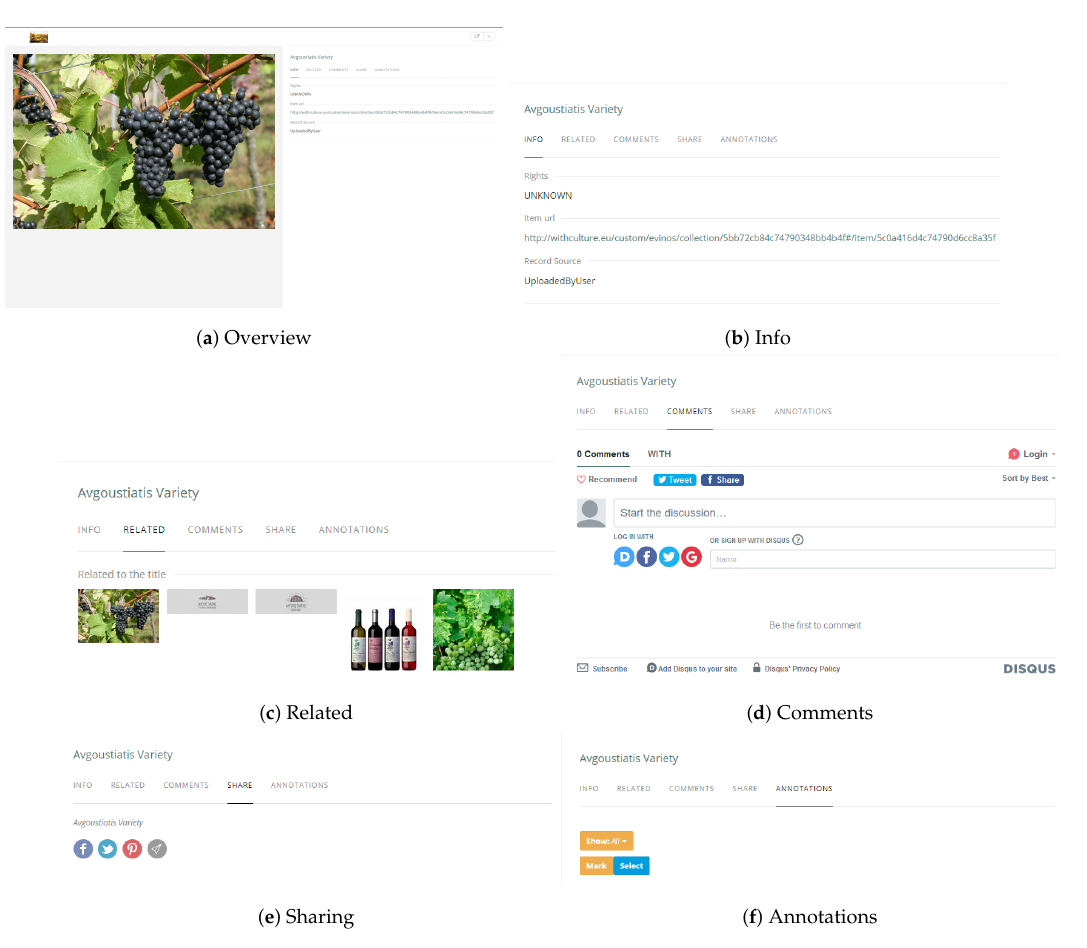
Figure 12. Knowledge base (KB) item